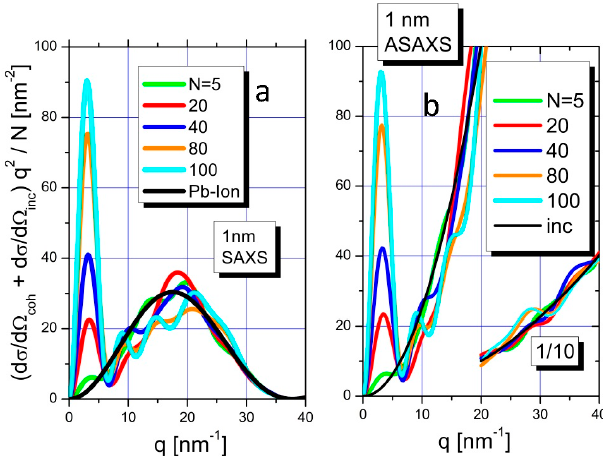
Figure 4. Kratky plot of scattering curves calculated from scattering curves of Pb 2+ ions confined in a cube of 1 nm side length by Monte Carlo simulation under the condition of a standard SAXS experiment ( a ). For the Pb 2+ ions a spherical form factor with a radius of 0.119 nm was assumed. The structure factor of 5, 20, 40, 80, and 100 Pb ions with randomly-distributed distances inside a real gas was simulated. The curves are normalized to N. The same simulations have been repeated for the real gas under the condition of ASAXS measurements using point-like scattering centers. For q -values beyond 20 nm − 1 the simulated curves are divided by 10 in order to better visualize ( b ).